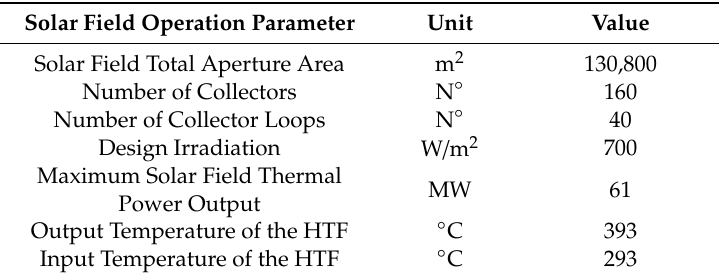
Table 1. The solar field design parameters